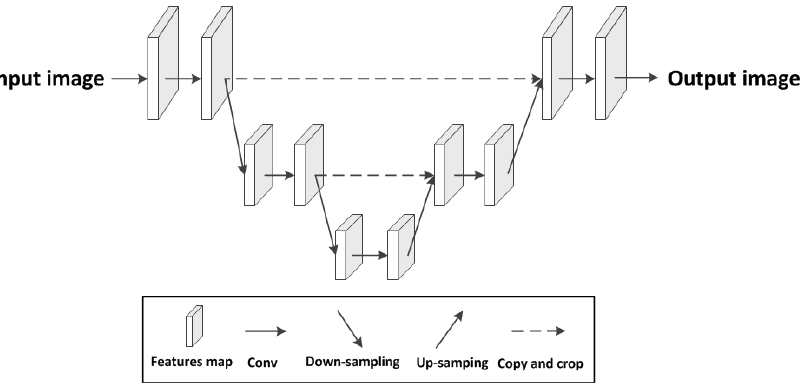
Figure 1. The architecture of the U-Net. The U-Net uses down-sampling to increase the receptive field and restores to the same resolution as the input image by